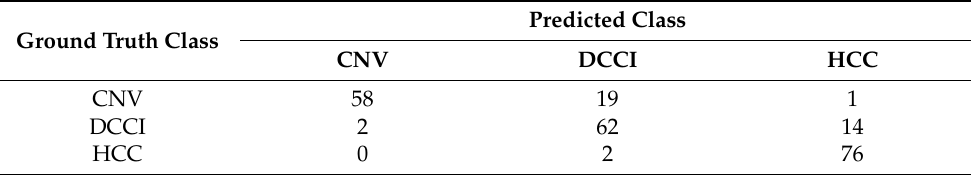
Table 4. Confusion matrix of the original VGG19 prediction on a balanced test dataset of 234 OCTA images (78 images for each class). CNV: choroidal neovascularization, DCCI: drusen/choriocapillaris impairment, HCC: healthy